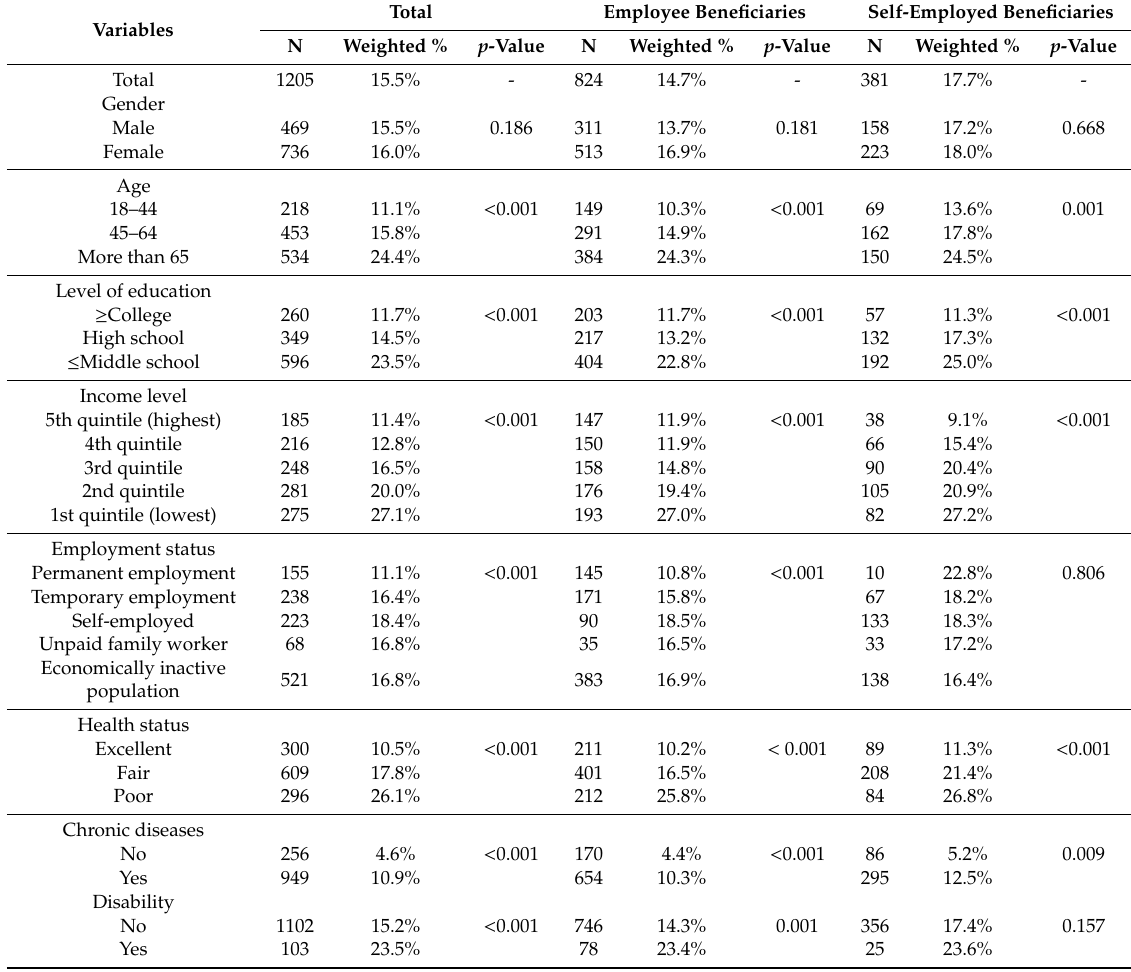
Table 1. The di ff erence rate of unmet dental needs between the type of NHI beneficiary,